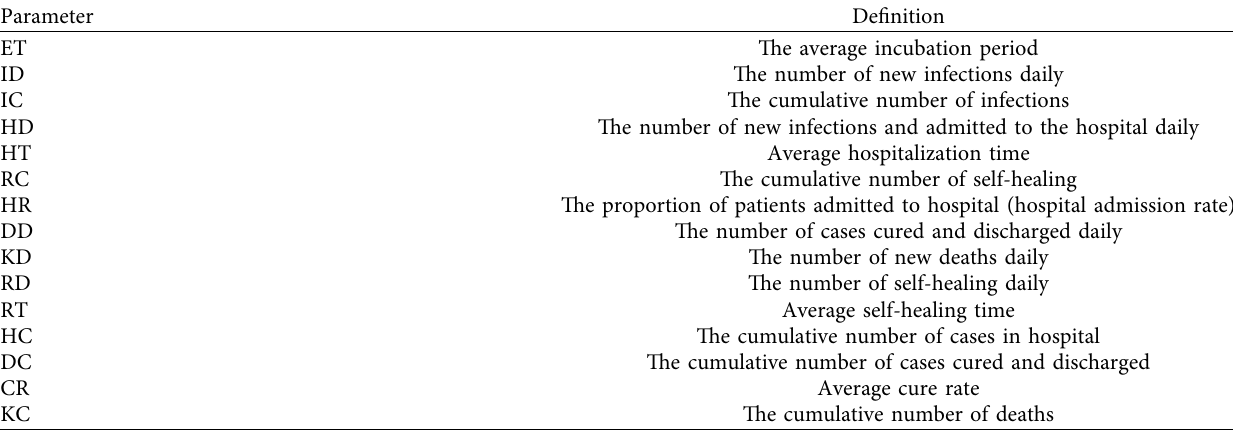
Table 3: Definition of parameters in Figure